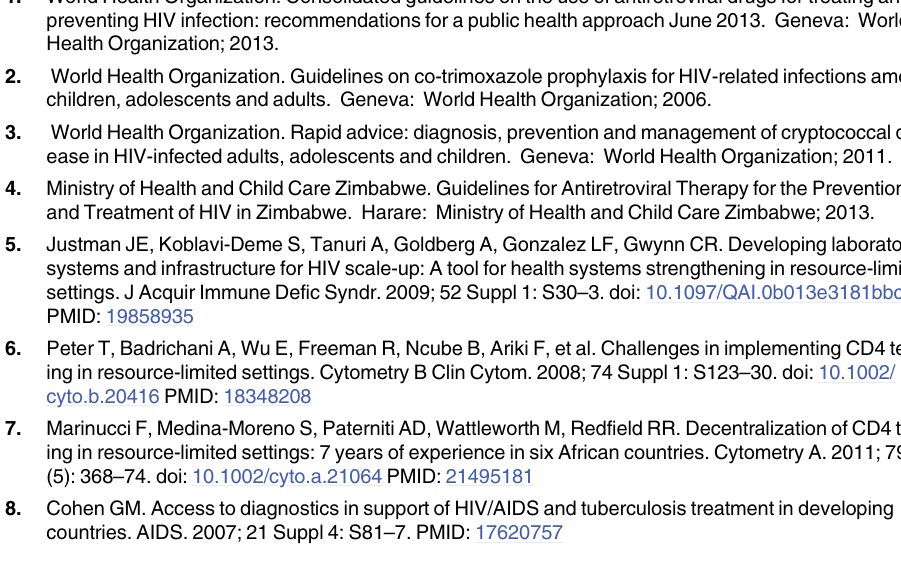
S2 Table. Agreement of BD Vacutainer CD4 Stabilization Tube sample results on Partec results on BD FacsCount at Day 0. S3 Table. BD Vacutainer CD4 Stabilization Tubes study